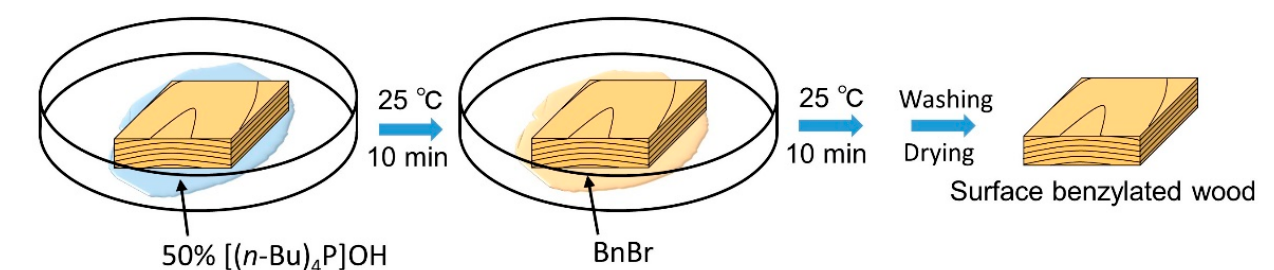
Figure 1. A typical benzylation process of block-shaped wood in this study.